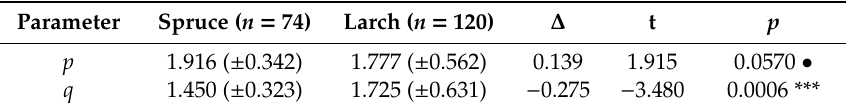
Table 4. Parameter estimates ( ± standard deviation) for p and q of the beta distribution by species. n is the number of sample trees. ∆ is the di ff erence between the species. t, the t-statistic for the test of the di ff erence against zero, and p , the respective type-one error probability. • and *** indicate the significance for type-one error probabilities of 10% and 0.1%, respectively.